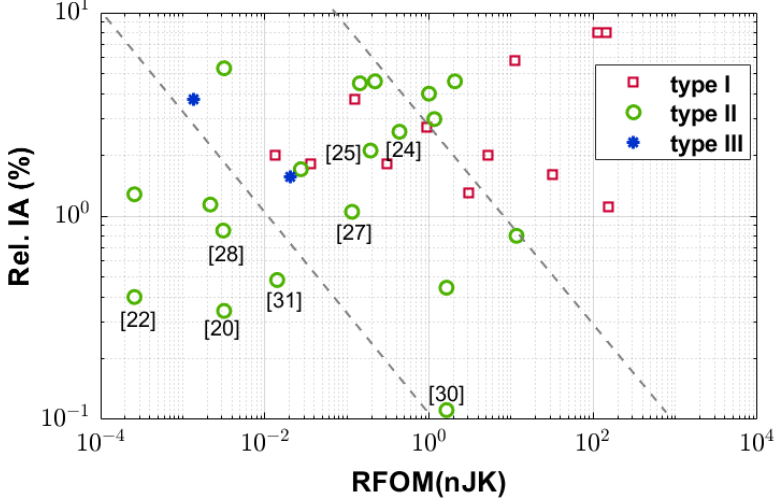
Figure 16. The relative inaccuracy (Rel. IA) versus RFOM (a measure for energy efficiency), for all three types of MOS-based temperature sensors. The figure also shows the constant Rel. IA and RFOM product lines (gray dashed lines). The reference numbers are labelled next to the markers for type II sensors.